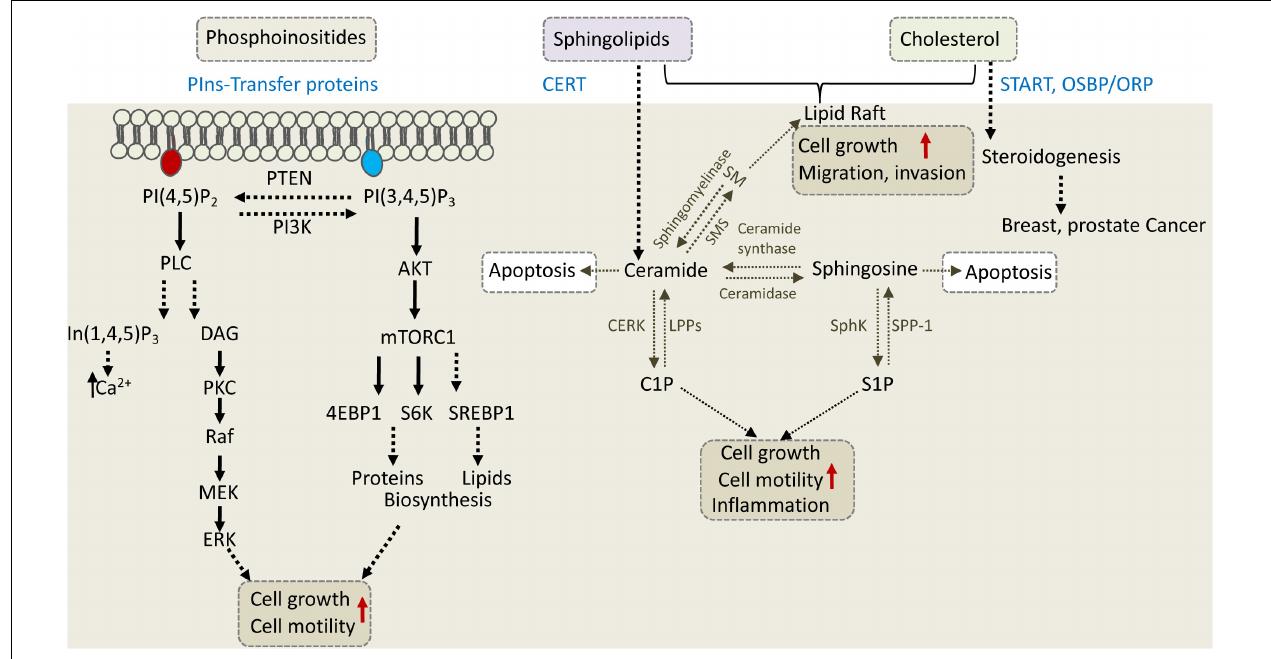
FIGURE 4 | Phosphoinositides, sphingolipids, and cholesterol regulate cell growth, motility, and invasion. The depicted cellular pathways are regulated by phosphoinositeds (PIns), sphingolipids, and cholesterol and can influence cell growth, motility, invasion, or apoptotic cell death. LTPs are labeled in blue and include PIns-transfer proteins, ceramide transfer protein (CERT), and various cholesterol transfer proteins of the START and OSBP/ORP family. PLC, phospholipase C; PKC, protein kinase C; DAG, diacylglycerol; S6K, S6 kinase; SM, sphingomyelin; SMS, SM synthase; S1P, sphingosine 1-phosphate; C1P, ceramide 1-phosphate; LPP, lipid phosphate phosphatase; SPP-1, S1P phosphatase-1; CERK, ceramide kinase; SphK, sphingosine